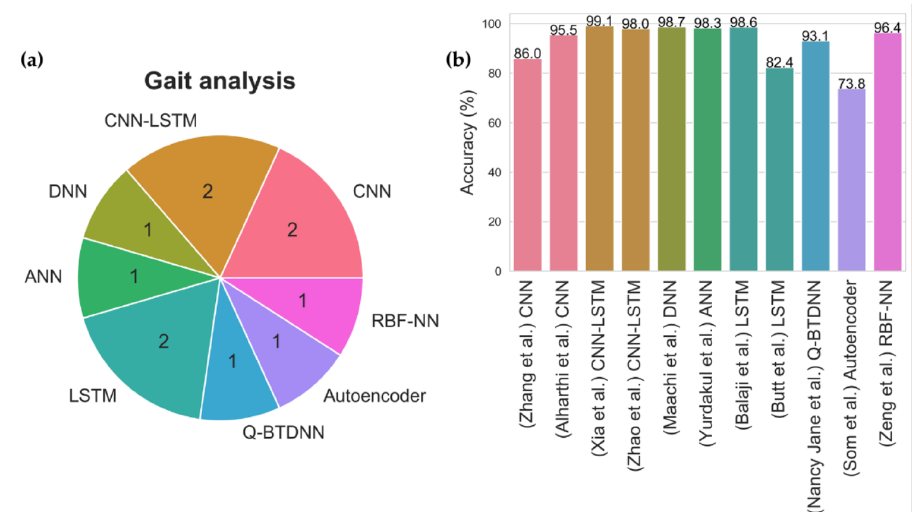
Figure 9. ( a ) Pie chart representation of various deep learning models proposed for gait analysis and ( b ) Bar chart representation of model accuracy for each deep learning study in gait analysis.